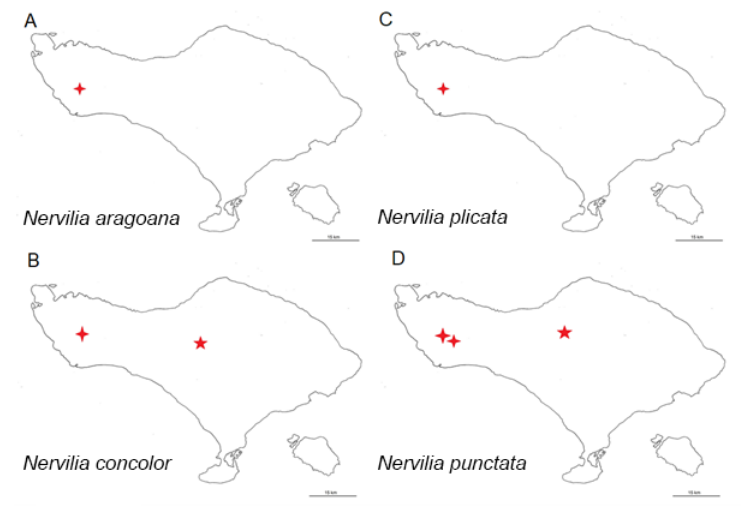
Figure 1 Approximate distribution maps of each species in Bali (a red asterisk stands for a new record reported in this paper; scale bar: 15 km). ( A ) Dewasana Forest, Jembrana Regency. ( B ) Mt Merbuk, Jembrana Regency (le) and Pura Pucak, Mt Batukaru (right). ( C ) Dewasana Forest, Jembrana Regency. ( D ) Pasatan Forest in Mendoyo District and Dewasana Forest, Jembrana Regency (right), Mt Batukaru and Bedugul, northeast of Lubang Nagaloka, Tebanan Regency